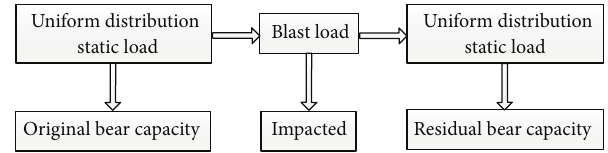
Figure 11: Flowchart of damage assessment program.